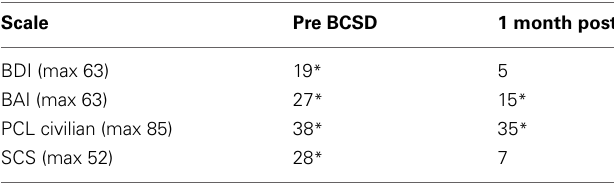
* Indicates scores in a clinically significant range based on scoring criteria for each instrument. BDI, Beck Depression Inventory; BAI, Beck Anxiety Inventory;